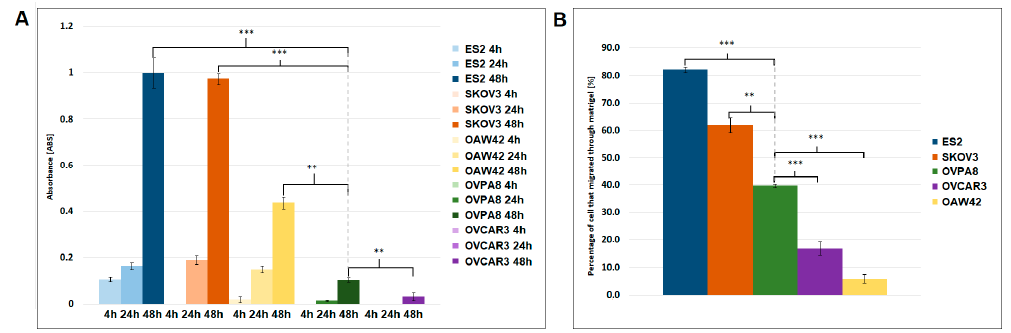
Figure 10. Analysis of cell migration and invasiveness. ( A ) Transwell cell migration assay. The OVPA8 cells showed low migration rate comparing to other ovarian cancer cell lines, except OVCAR3. Statistical significance is indicated for the results obtained after 48 h. For other time points similar significance level was obtained; ( B ) Matrigel invasion assay (96 h). The OVPA8 cell line showed intermediate invasion ability comparing to other ovarian cancer cell lines; **— p < 0.001 ***— p < 0.0001.